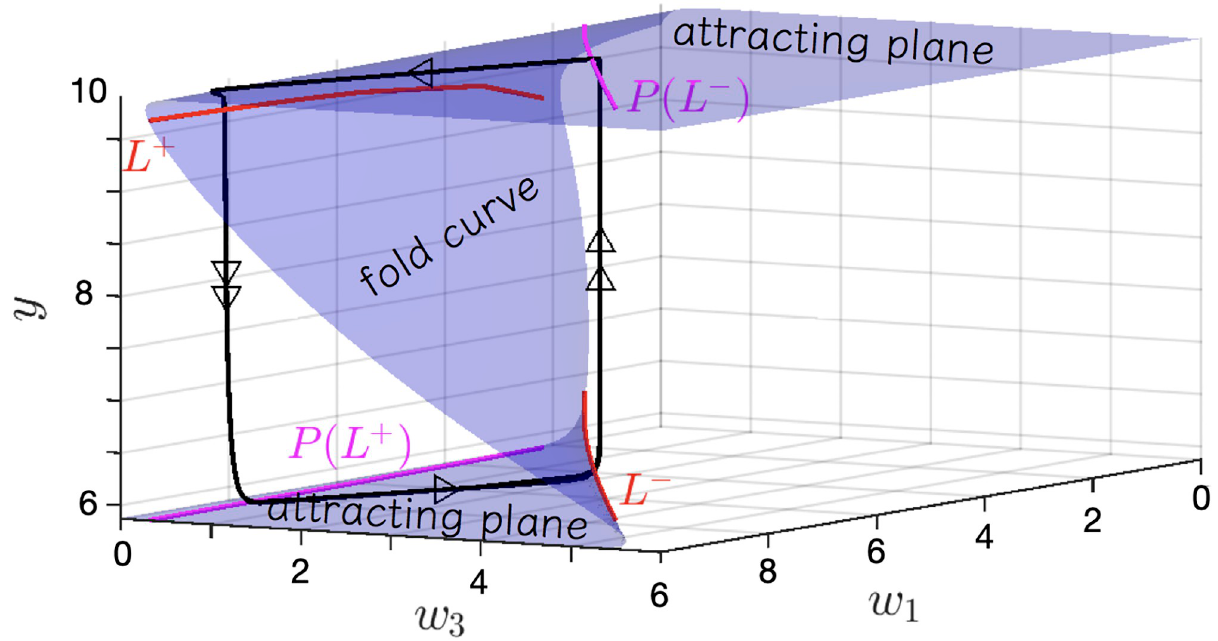
Fig 5. The slow manifold of institutional change. The vertical axis y is the abundance of agent y (we could as easily have shown I mappings from y and x ). The learning axes, w 1 and w 3 capture the learned effort invested by populations of agents x in supporting their own institution through their public ledge values I x while opposing rival institutions and their position values I y . The dynamical system remains tethered to this 2-dimensional plane such that when the learning parameters cross certain threshold values a sudden change in the abundance of y is observed. High values of w 1 and low values of w 3 are associated with low values of y and high values of x . The explanation for the shape of this manifold derives from the relative rates of change of agent abundance versus learning and hence the institutional time scales. The flat portion of the manifold reflects the quasi- stationary solutions of the fast dynamics for a given range of values of w i . The folds of the manifold are traversed when these slow learning parameters reach a critical ‘transmission’ threshold with respect to the faster agent scale dynamics in x and y . In this way the folds of the manifold appear to be equilibrium solutions to a low dimensional system whereas they are in fact flat portions of trajectories in a high dimensional